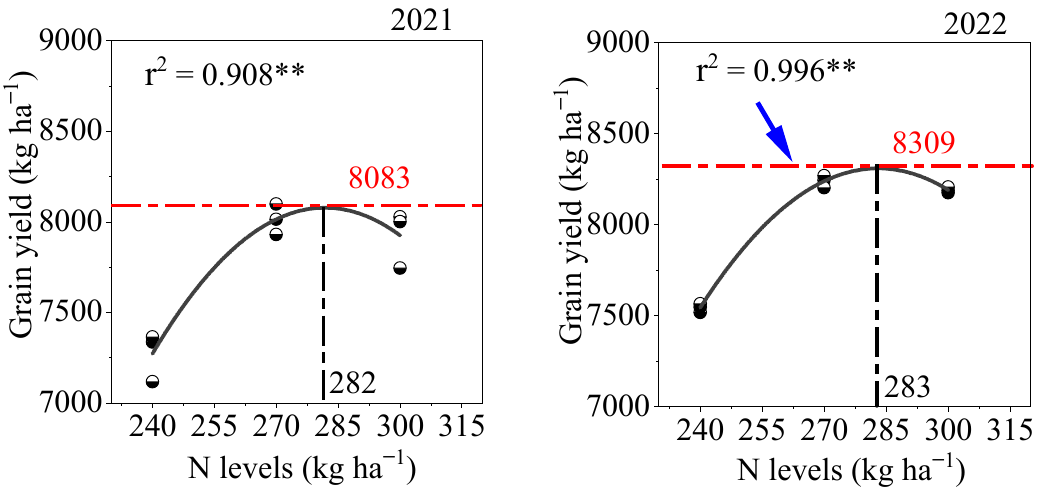
Figure 5. The relationship between SPAD values and N application levels at different growth stages of wheat. The SPAD values were measured in the L1–M of wheat. * and ** indicate significant dif- ferences at 0.05 and 0.01 levels, respectively. Blue arrows represent the function that has the higher correlation coefficient (r 2 ) between SPAD values and N application levels at the same growth stage in different years.